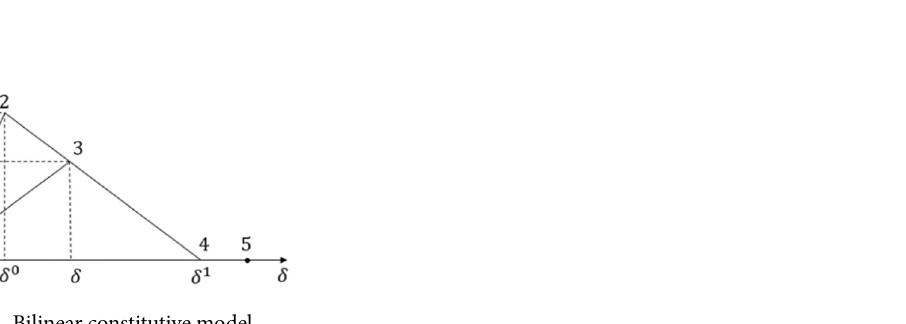
Figure 3. Bilinear constitutive